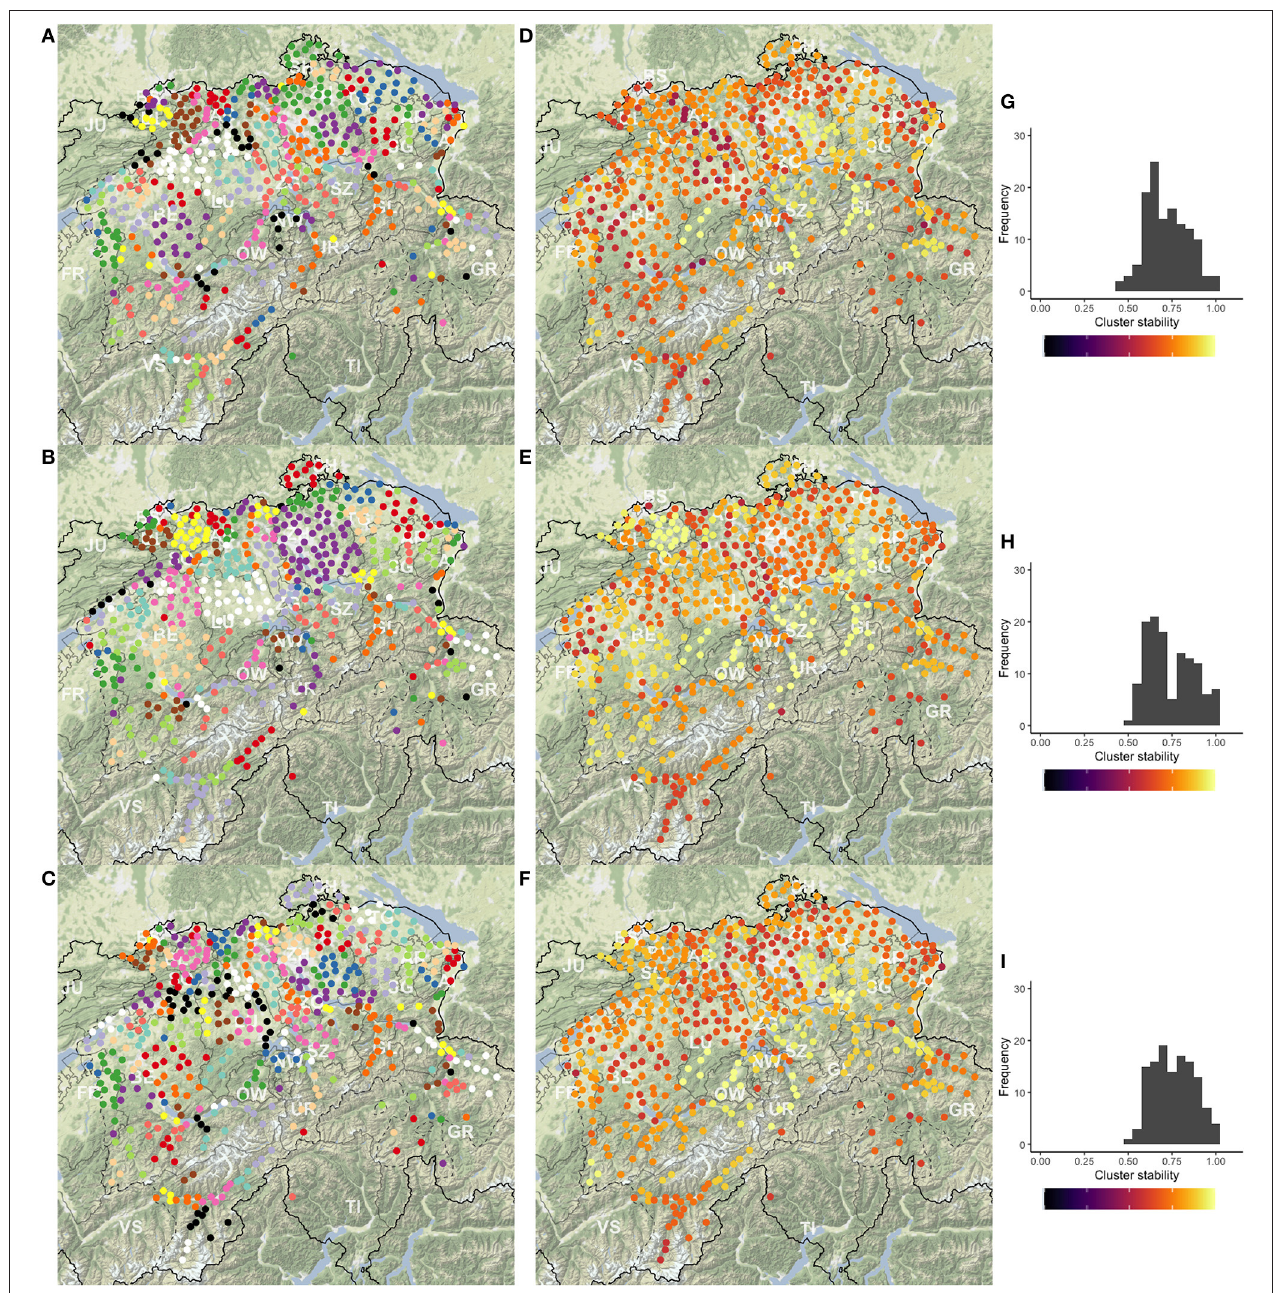
FIGURE 2 | The cluster maps (A–C) , stability maps (D–F) , and the stability histograms (G–I) for the three clustering methods PAM (top), UPGMA (center), and Ward’s (bottom) method, calculated for k = 125 clusters. Clusters in maps (A–C) are presented on a diverging scale of 15 colors, which repeat. Substantial differences are visible across the cluster solutions and smaller differences across the stability of the clusters across the methods. Importantly, clusters in some regions stay stable independent of the clustering